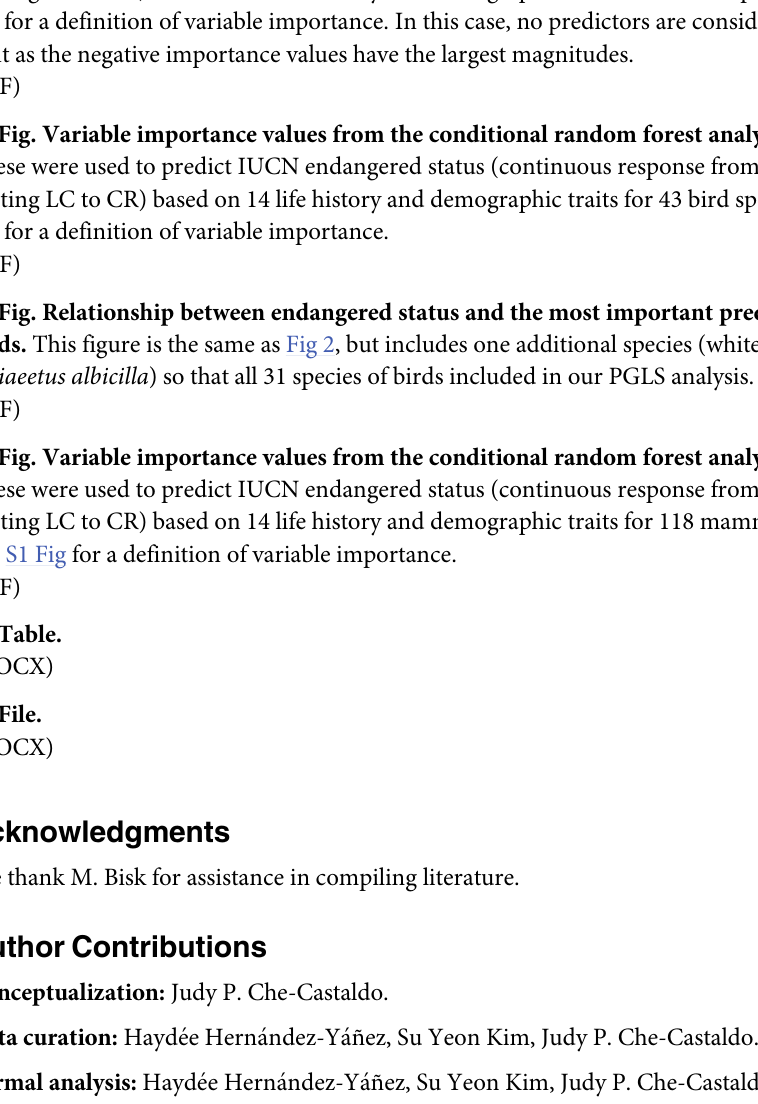
S2 Fig. Variable importance values from the conditional random forest analysis for trees. These were used to predict IUCN endangered status (continuous response from 1 to 5, repre- senting LC to CR) based on 14 life history and demographic traits for 48 tree species. See S1 Fig for a definition of variable importance. In this case, no predictors are considered signifi- cant as the negative importance values have the largest magnitudes. S3 Fig. Variable importance values from the conditional random forest analysis for birds. These were used to predict IUCN endangered status (continuous response from 1 to 5, repre- senting LC to CR) based on 14 life history and demographic traits for 43 bird species. See S1 Fig for a definition of variable importance. S4 Fig. Relationship between endangered status and the most important predictors for birds. This figure is the same as Fig 2, but includes one additional species (white tailed eagle; haliaeetus albicilla ) so that all 31 species of birds included in our PGLS analysis. S5 Fig. Variable importance values from the conditional random forest analysis mammals. These were used to predict IUCN endangered status (continuous response from 1 to 5, repre- senting LC to CR) based on 14 life history and demographic traits for 118 mammal species. See S1 Fig for a definition of variable